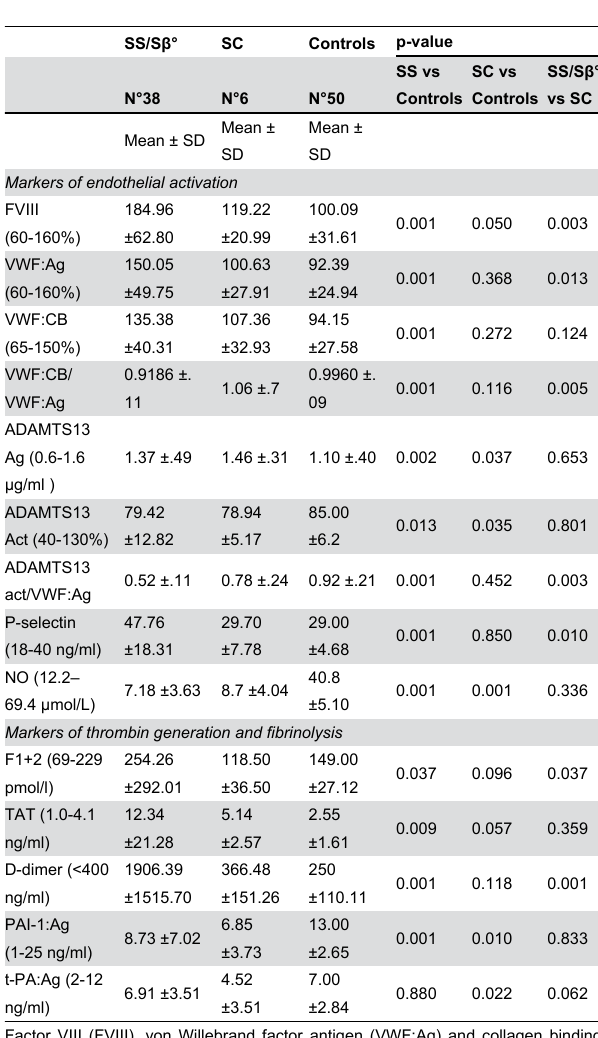
Table 3. Markers of inflammation and hemolysis significantly correlated with the majority of the coagulation parameters.